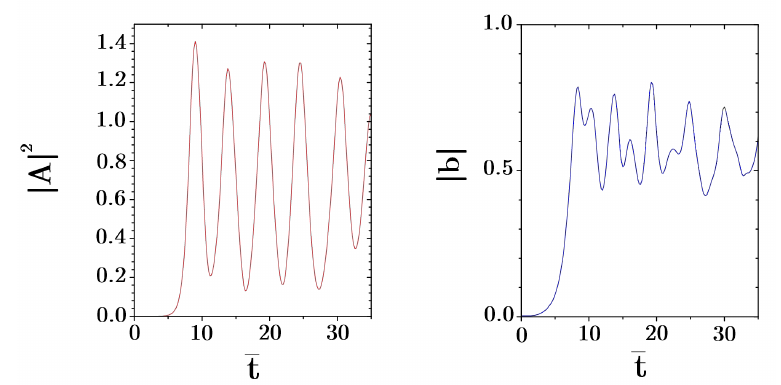
Figure 4. | A | 2 and | b | vs. ¯ t for ¯ δ = 0 and ¯ κ = 0. The maximum scaled intensity is about 1.4, meaning that each atom backscatters in average 1.4 ρ photons. The maximum bunching is about 0.8 which corresponds to a well resolved density grating. Intensity and bunching show undamped nonlinear oscillations after the first